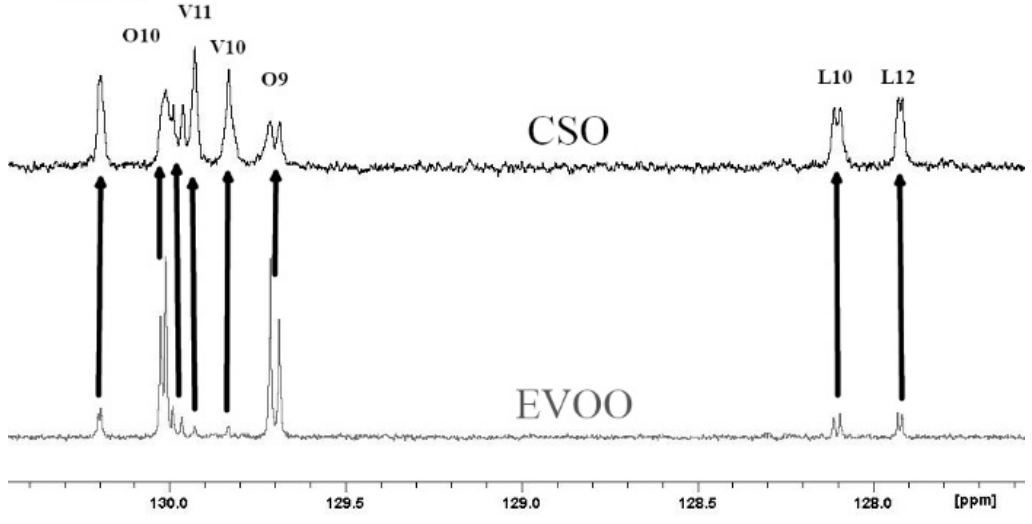
Figure 3. 13 C-NMR profiles for olive oil (EVOO) in gray and capparis seed oil (CSO) in black. All the assignments for oleic (O), linoleic (L) linolenic (Ln) and cis -vaccenic (V), with the number representing carbon atom position respect to the 1 carboxyl position, are pretty known and coherent with quantitative and literature data.